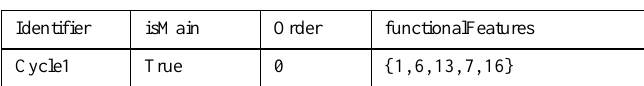
F RAME I NSTANCES FOR T OPOLOGICAL C